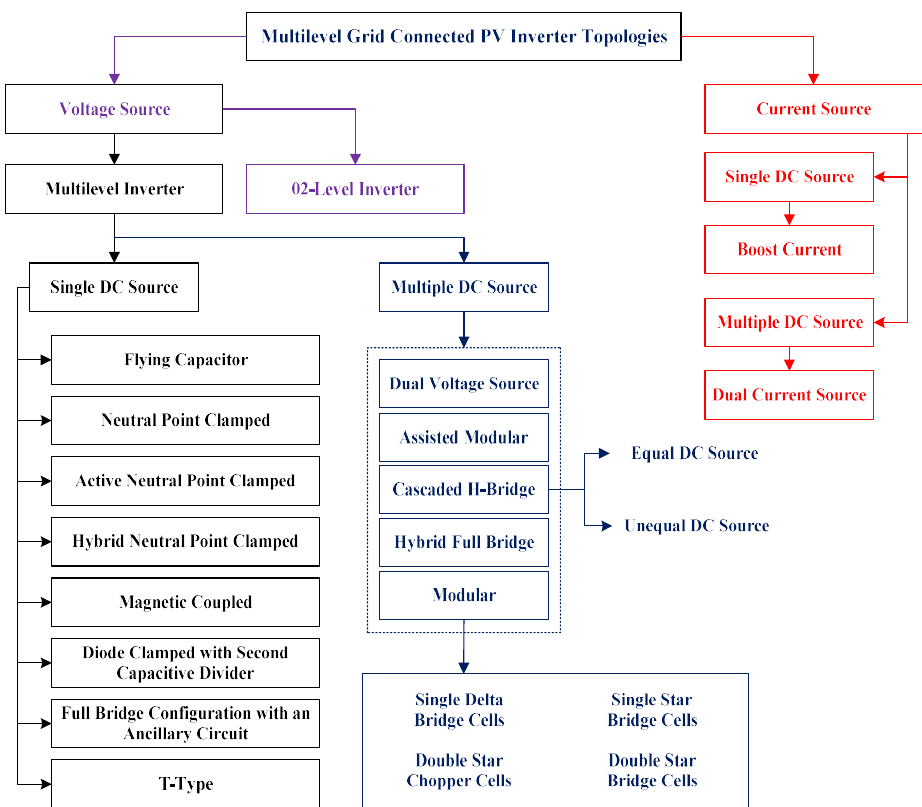
Figure 5. Classification of multi-level grid-connected inverters based on power circuit structure.